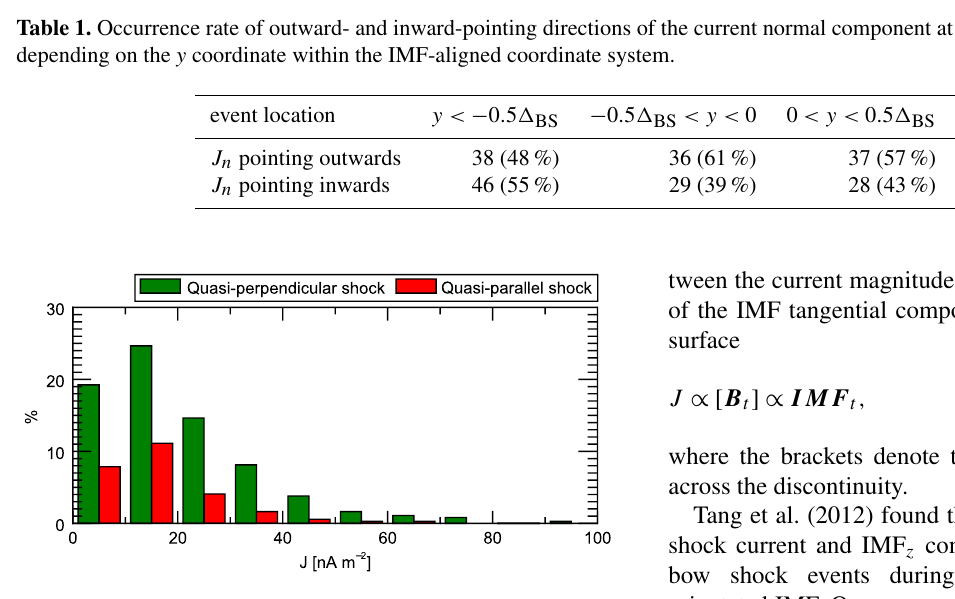
Figure 7. Occurrence rate of bow shock current magnitudes with a 10nAm − 2 binning interval.